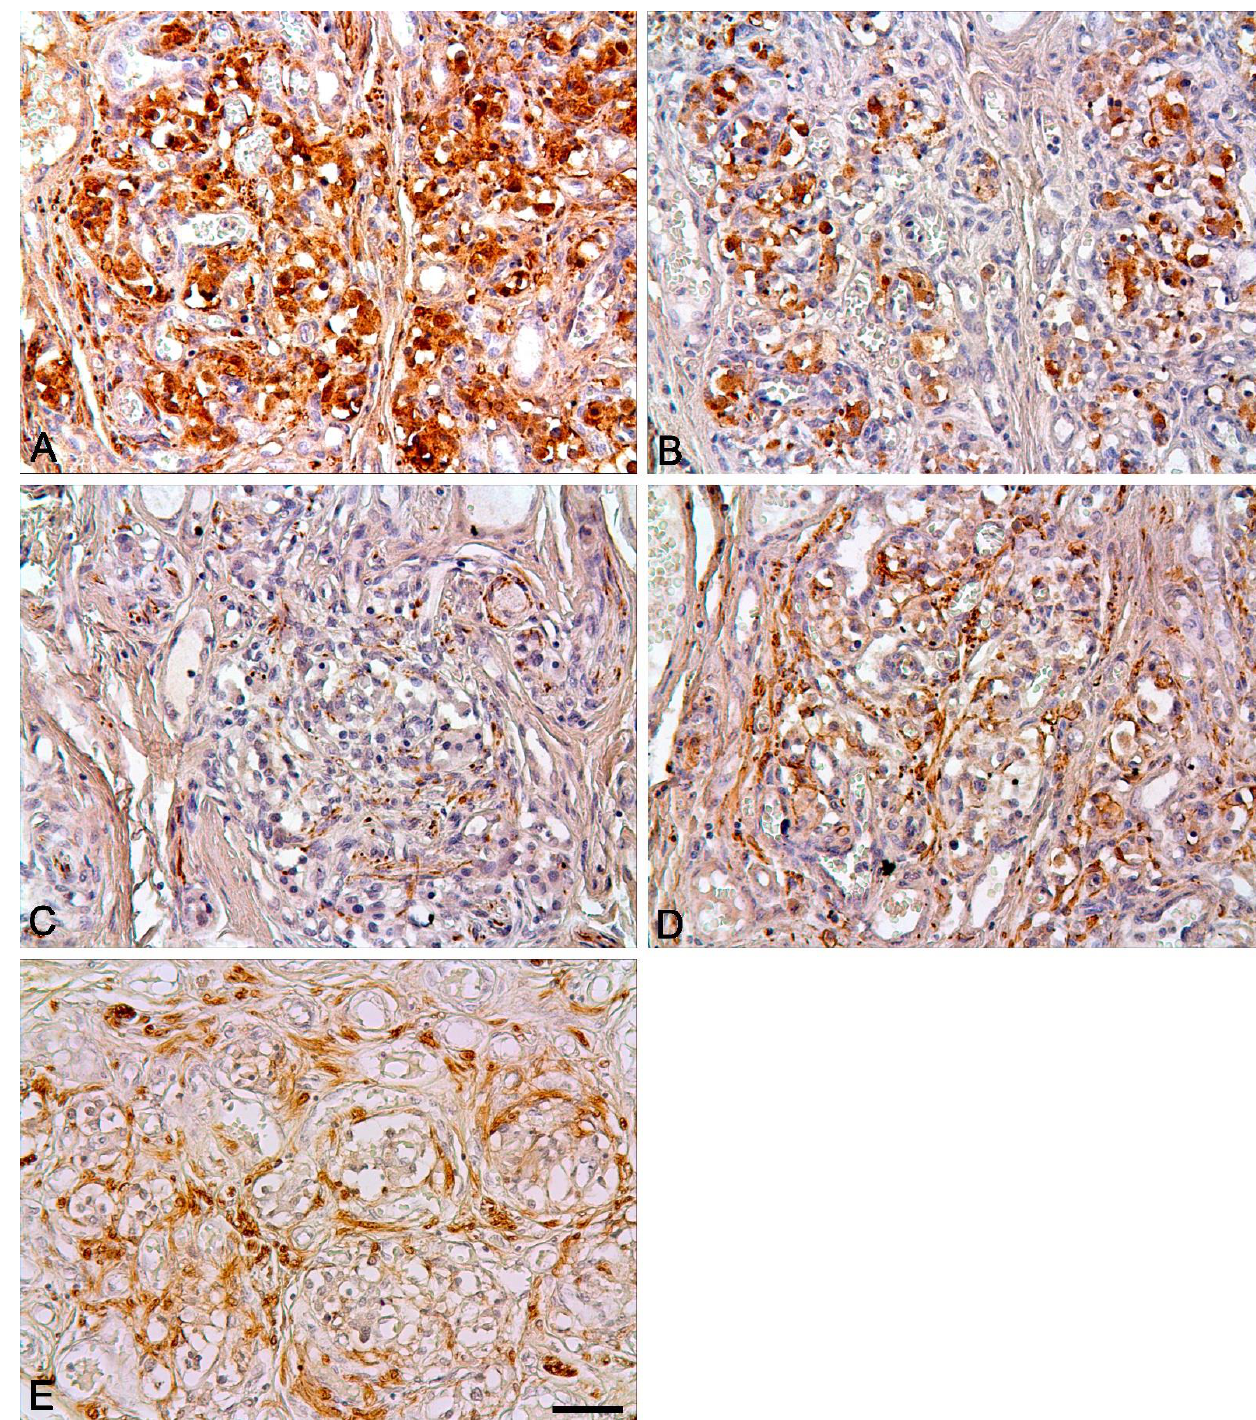
Figure 4. The human carotid body in the postnatal period. Expression of PGP9.5 ( A ), synaptophysin ( B ), neurofilaments ( C ), GFAP ( D ) and S100 ( E ). Nuclei stained with hematoxylin. Bar = 50 μm.